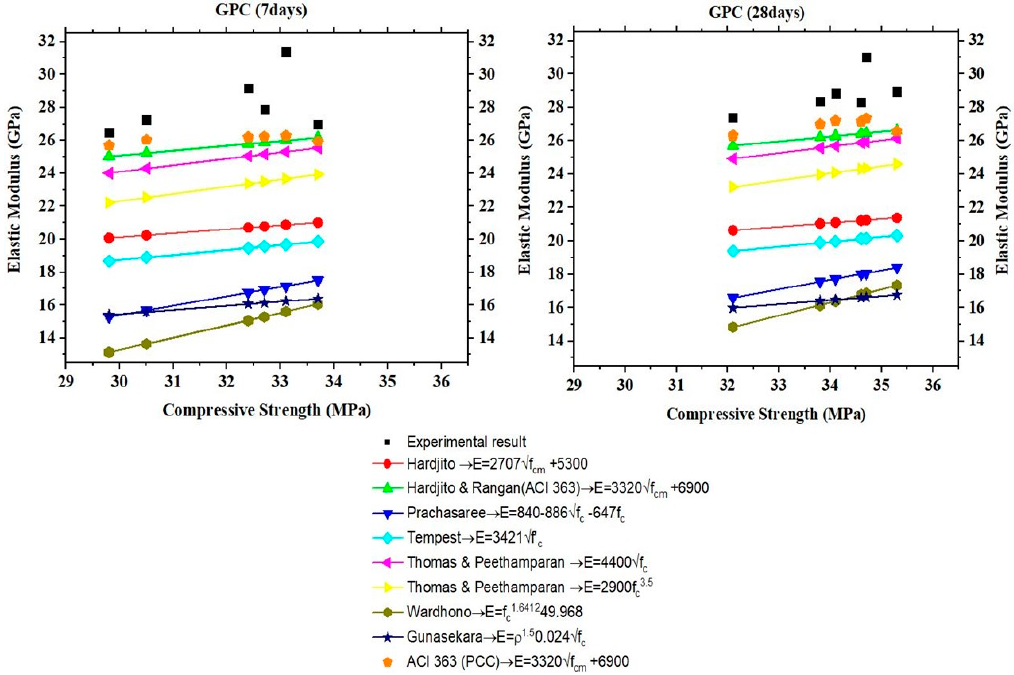
Figure 7. Comparison between predicted and experimental modulus of elasticity.